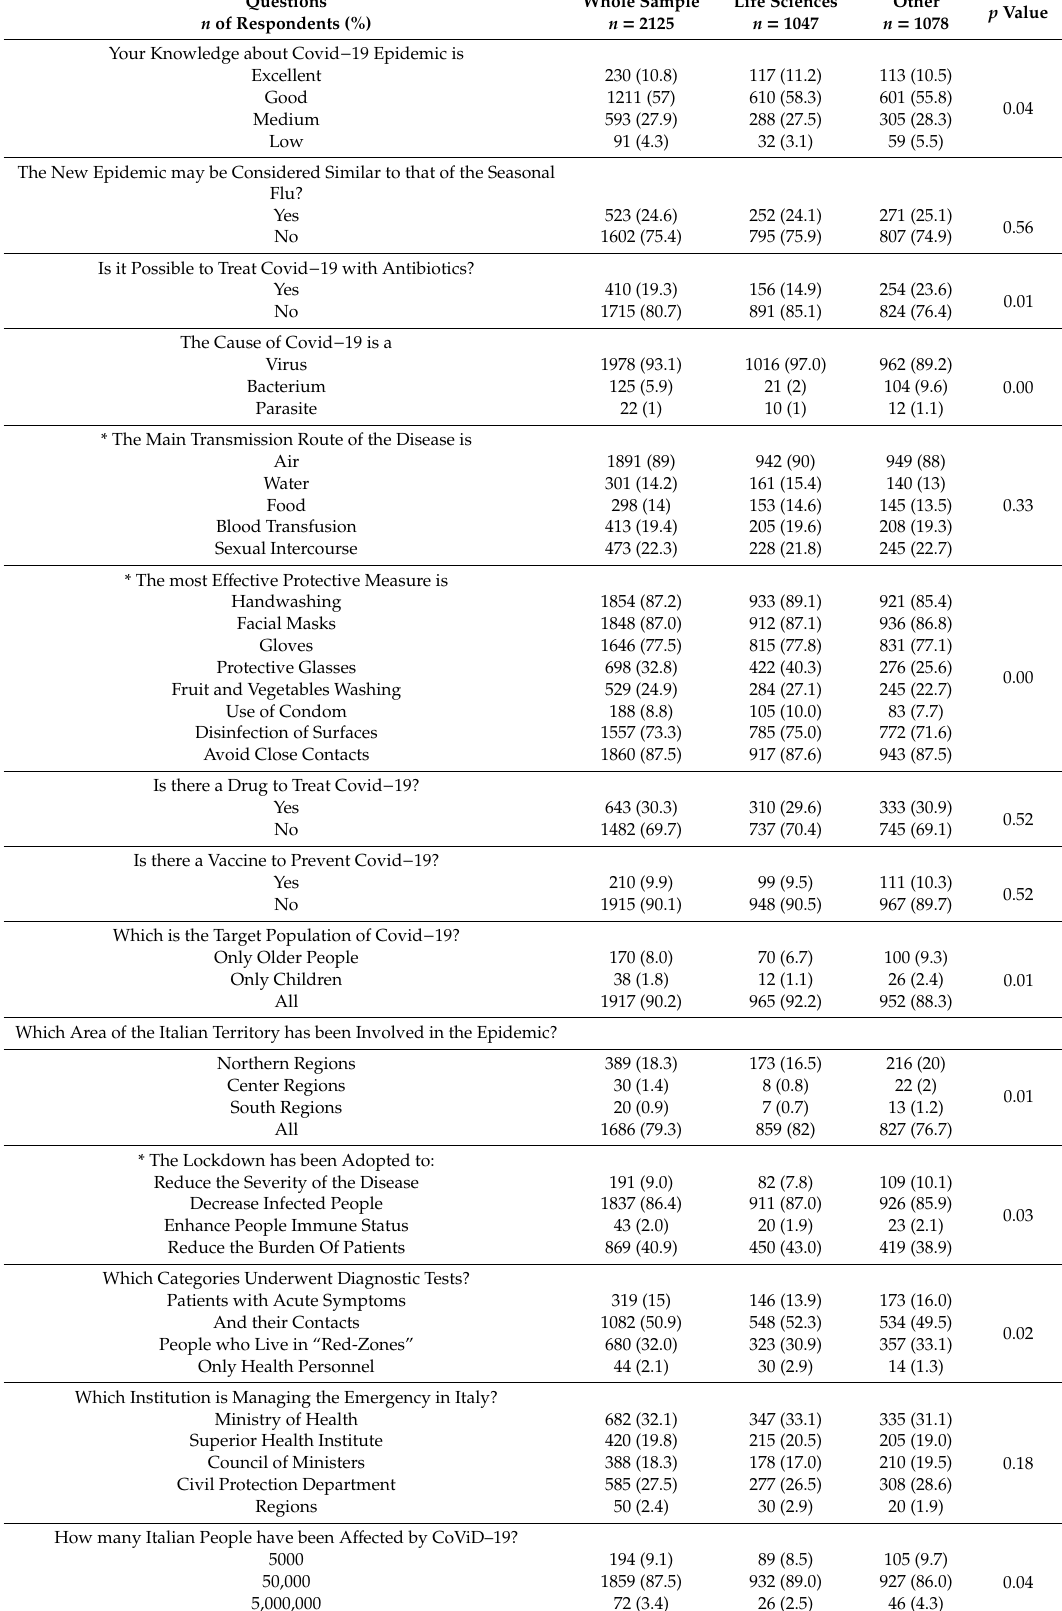
Table 2. Answers provided by students regarding the CoViD–19